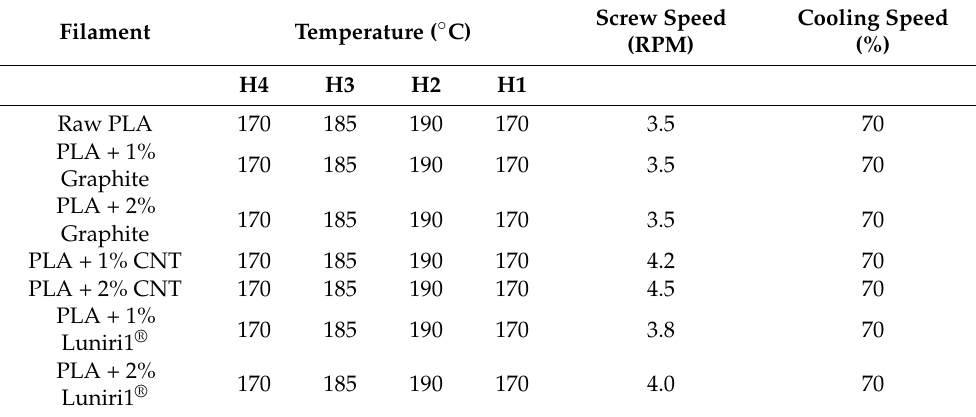
Table 3. Processing parameters during PLA filament